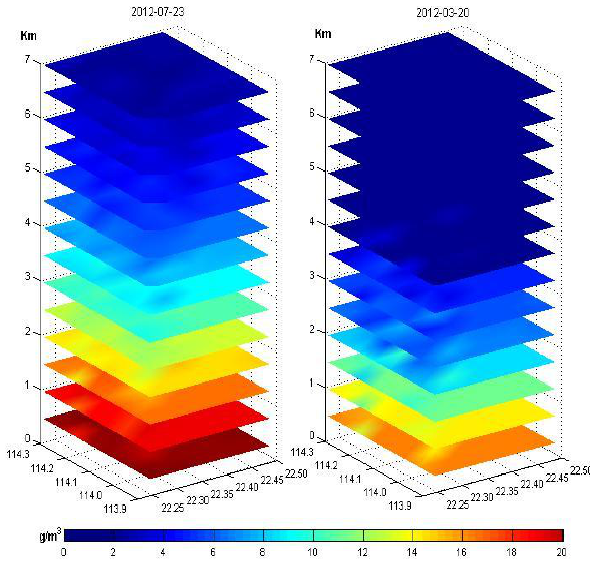
days. It was rainy on 23 July 2012 while it was cloudy on 20 March 2012 in Hong